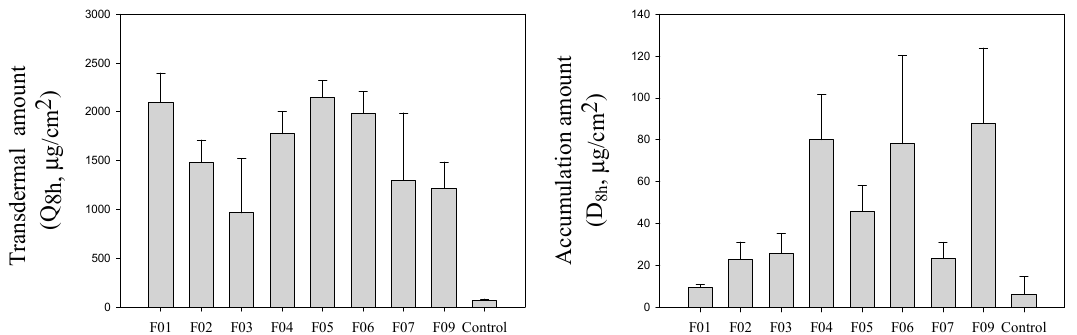
Figure 1. The permeability parameters of model gemcitabine-loaded formulations and control group (1% gemcitabine solution).